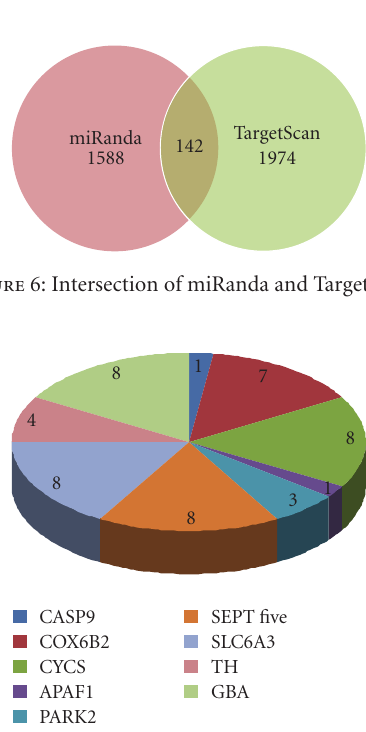
Figure 7: Common target sites predicted using miRanda and Targetscan, where datalabels show the number of target sites predicted for each